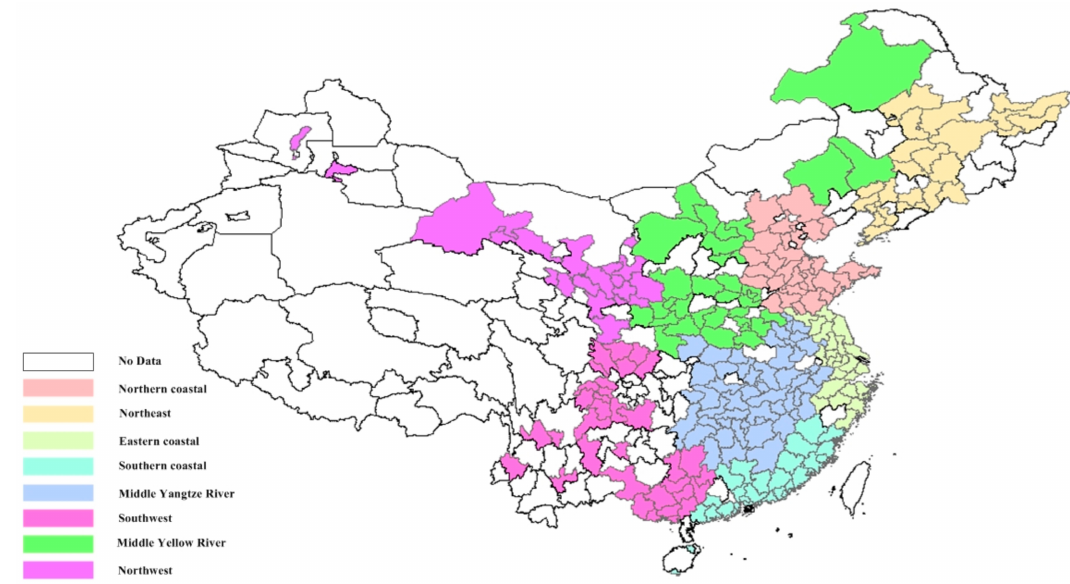
Figure 1. The illustration of the selected urban observations divided by